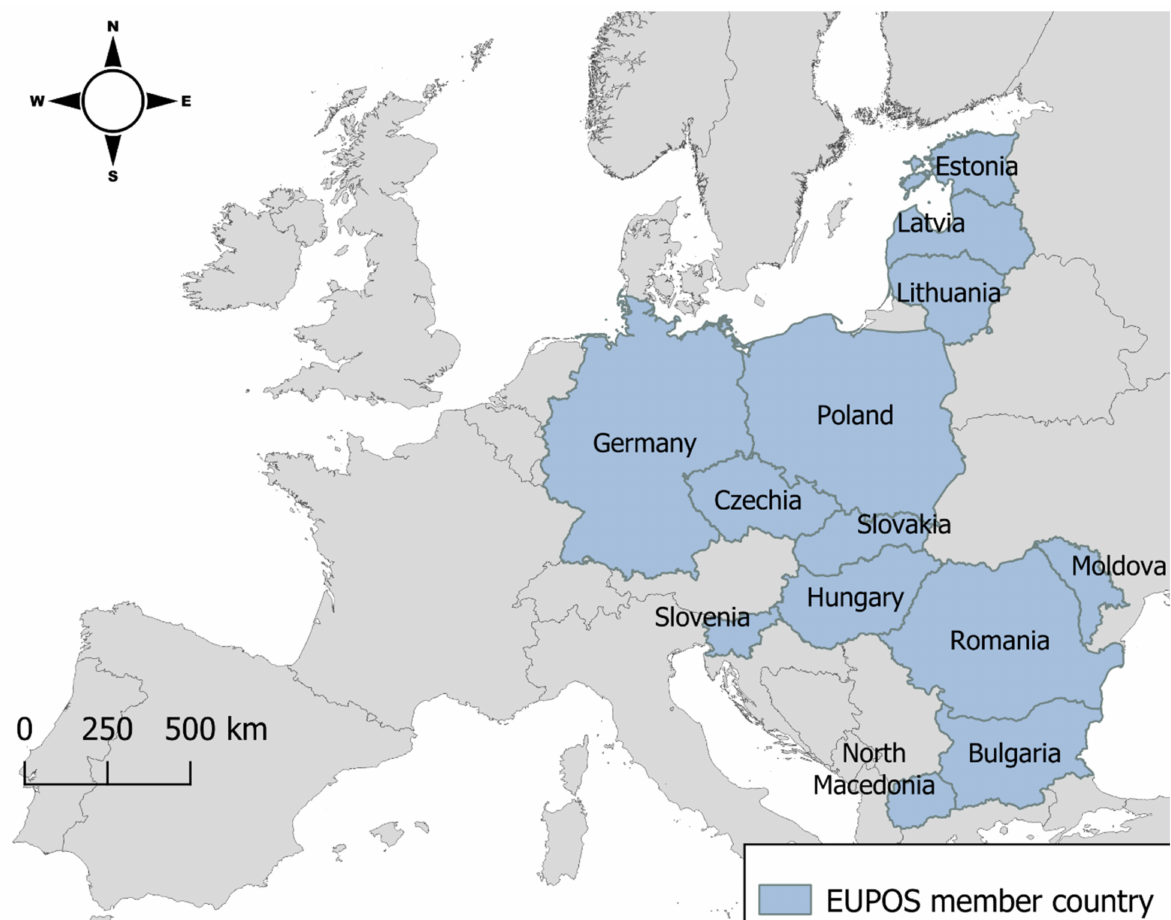
Figure 1. The range of the EUPOS, source: original work based on European Commission, Eurostat (ESTAT), GISCO Countries, 2020—Administrative